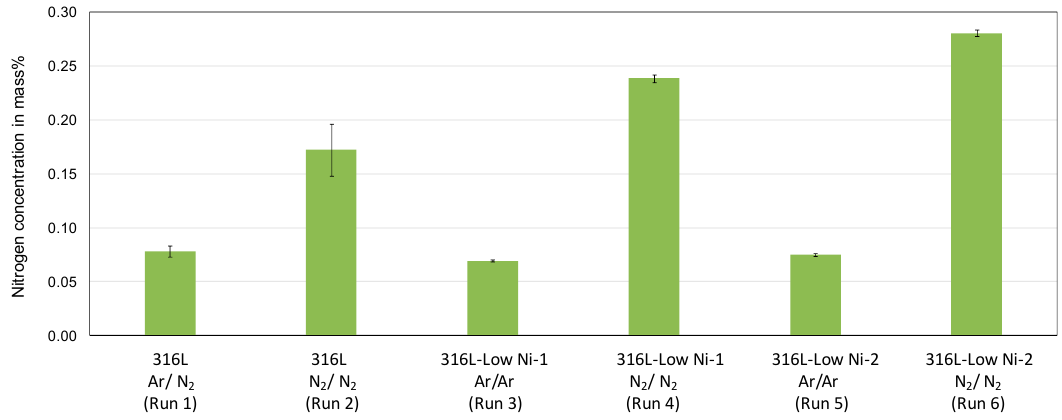
Figure 6. Concentration of N in gas atomized 316L and modified 316L steel powders, measured by means of carrier hot gas extraction.